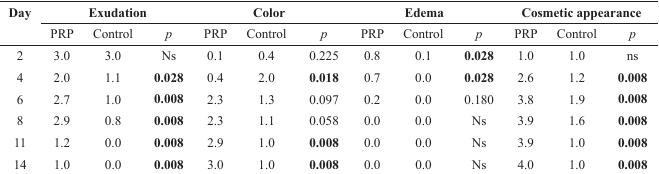
TABLE 3 - Average scores for the clinical evaluation of the PRP group (control versus PRP).